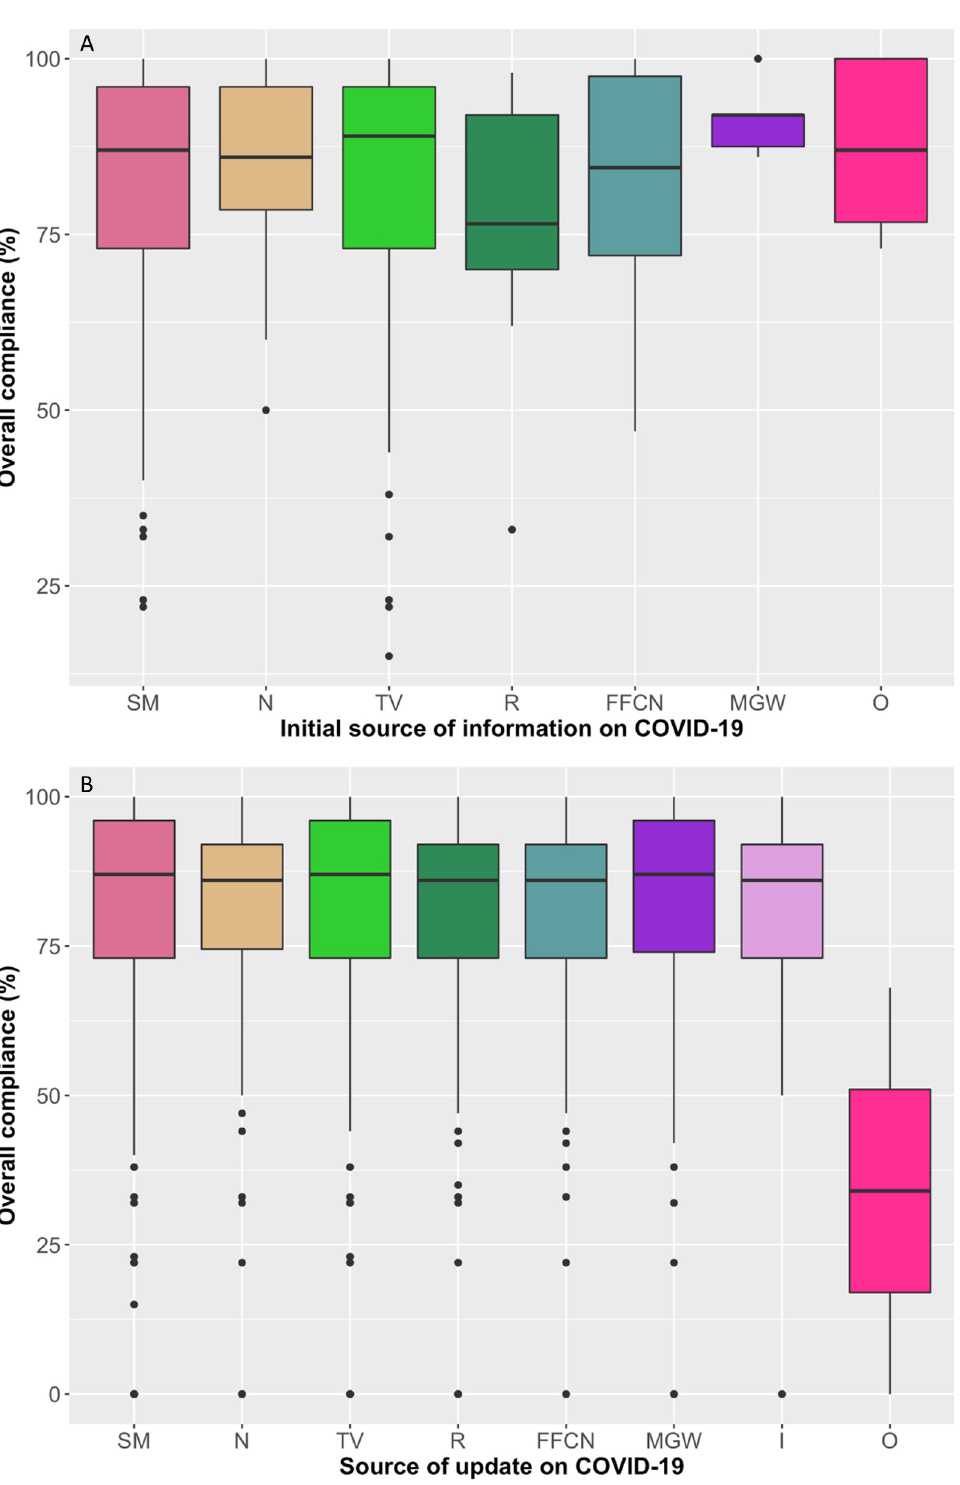
Fig 6. A. Overall compliance of respondents disaggregated by the source of media from which respondents initially heard about COVID-19 B. Overall compliance of respondents disaggregated by sources of media used by respondents to continue to stay up to date about COVID-19. Abbreviations: SM = social media, N = newspaper, TV = television, R = radio, FFCN = family friends colleagues or neighbours, MGW = Ministry of health or Government of Kingdom of Eswatini websites, O = other, I =